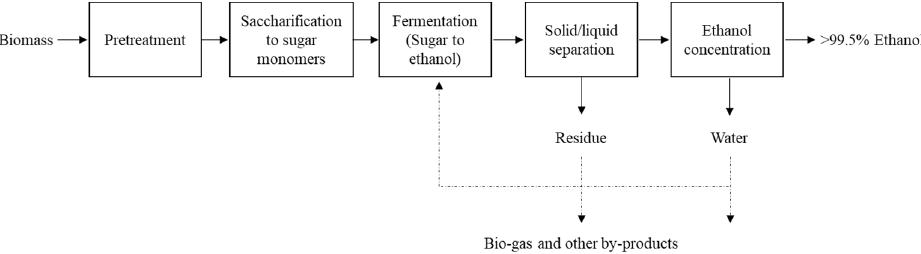
Figure 1. Overview of a bio-ethanol production process.